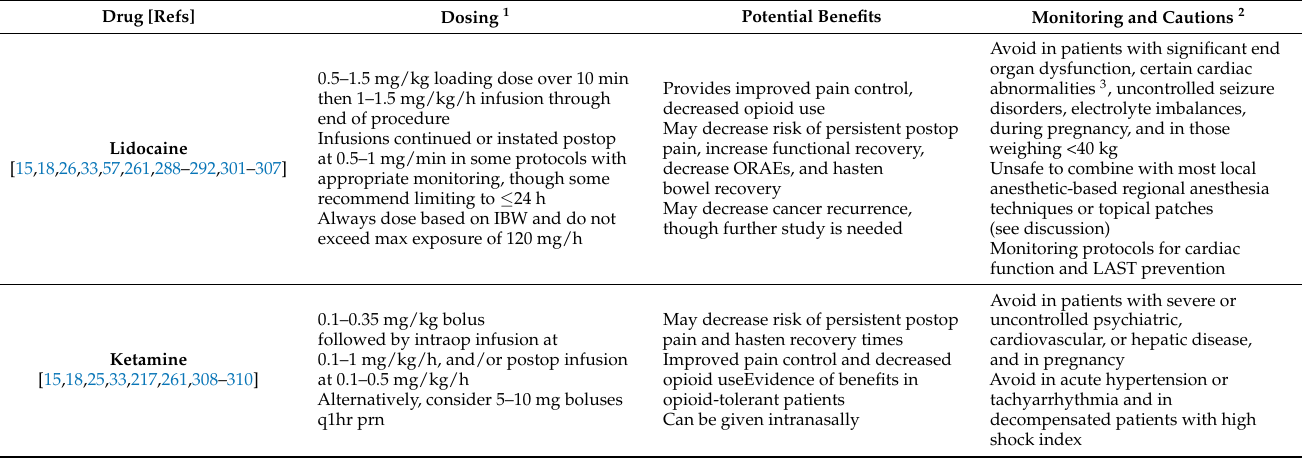
Table 6. Clinical Considerations for Intraoperative Systemic Multimodal Analgesics. Drug